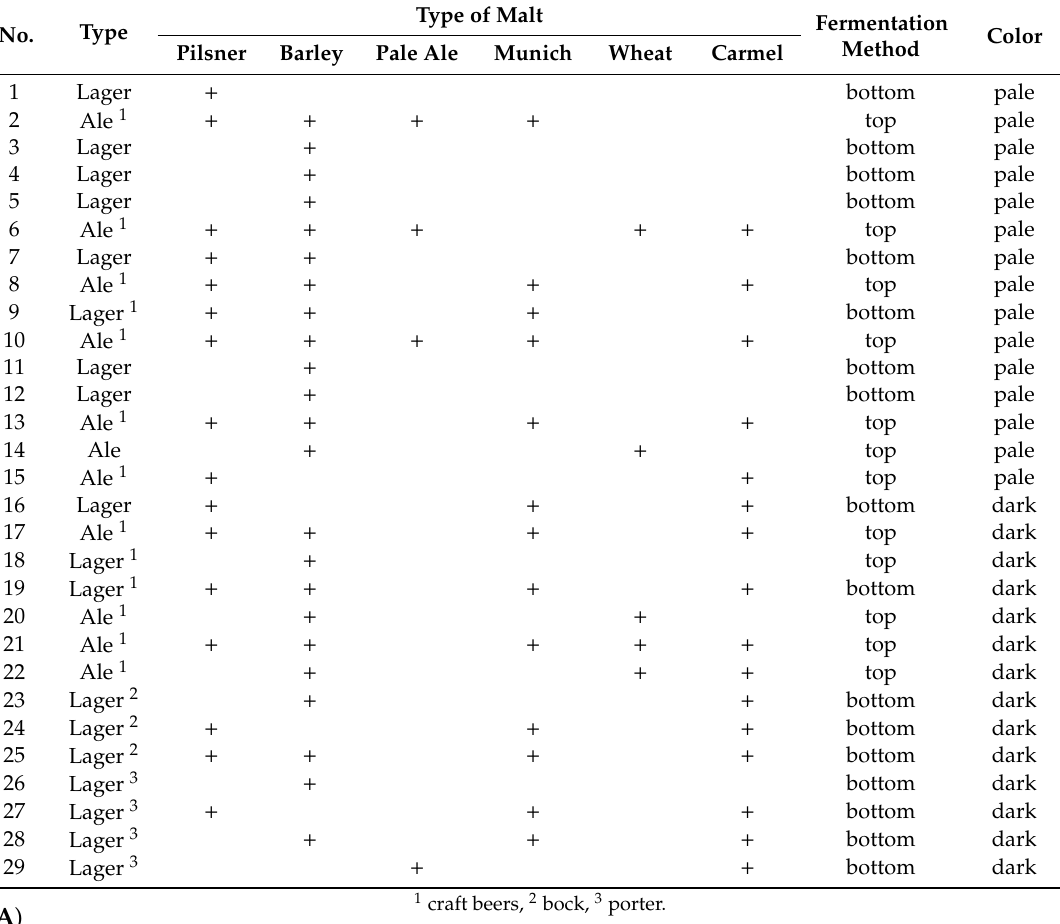
Table 2. ( A ) Type and style, ( B ) physicochemical parameters, the total phenolic content, antioxidant activity and ( C ) concentration of elements of Polish beers analyzed in this study ( n =